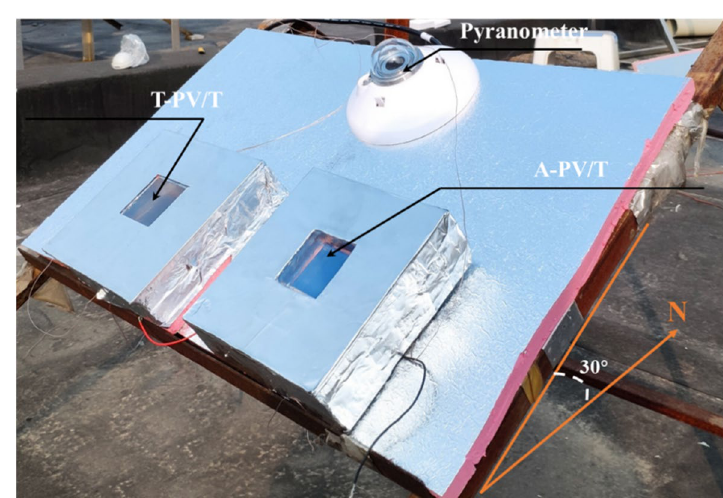
Fig. 6 Photo of the outdoor experiment setup